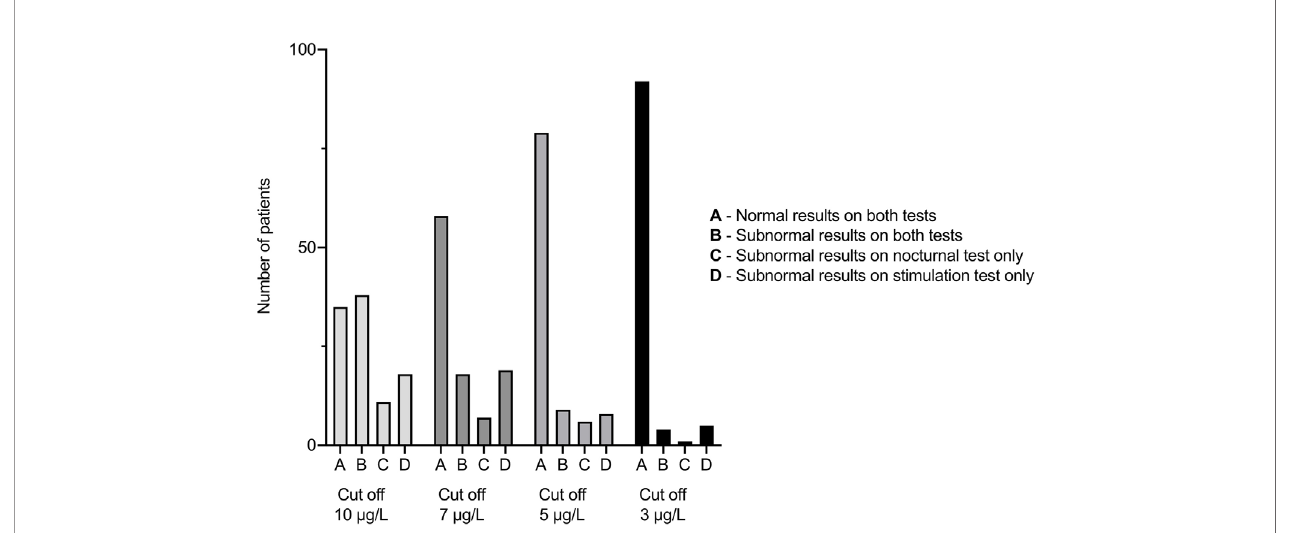
FIGURE 2 | Number of children with short stature evaluated for possible GHD by both a nocturnal spontaneous GH test and an AITT in groups A – D, applying different cut-off levels for peak GH values. AITT, arginine-insulin tolerance test. GH, growth hormone. GHD, growth hormone de fi